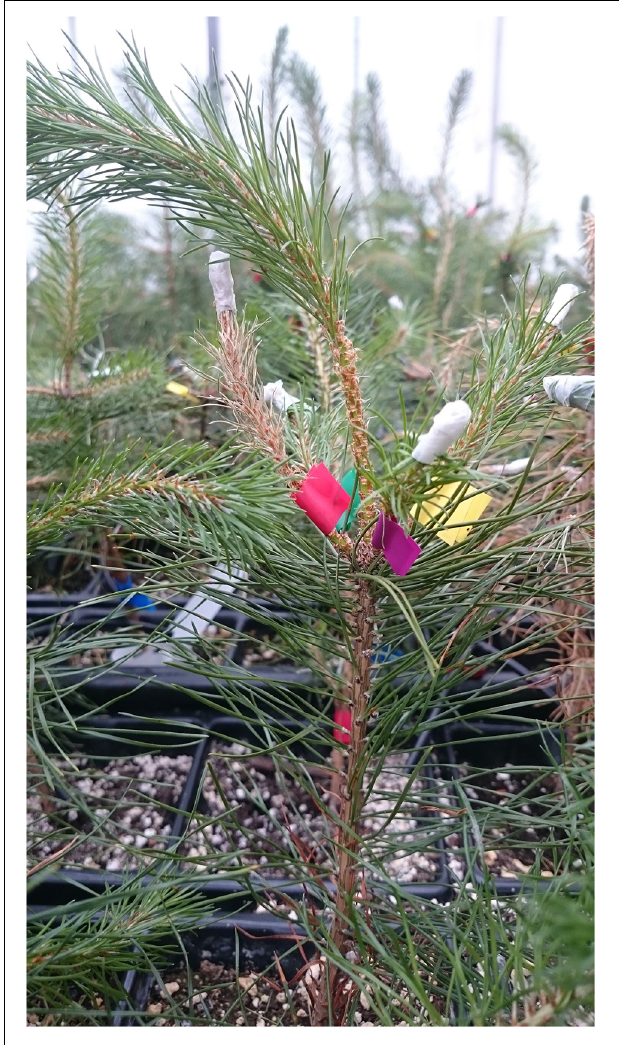
FIGURE 6 | Pine shoot with combined infections at the end of the experiment. The red labeled side-shoot was infected with S. sapinea and shows full